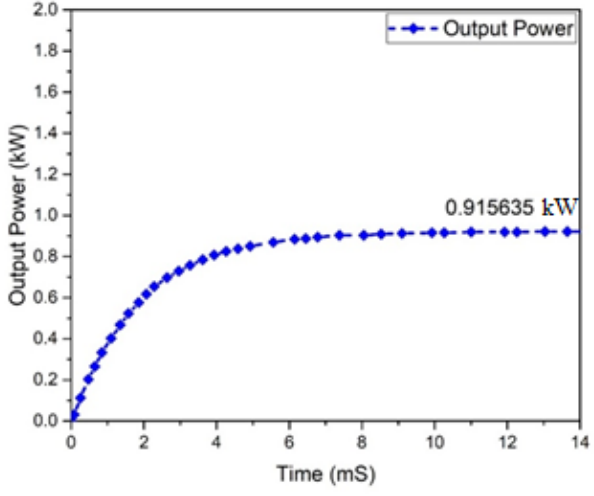
Figure 18. Output power of interleaved boost converter.